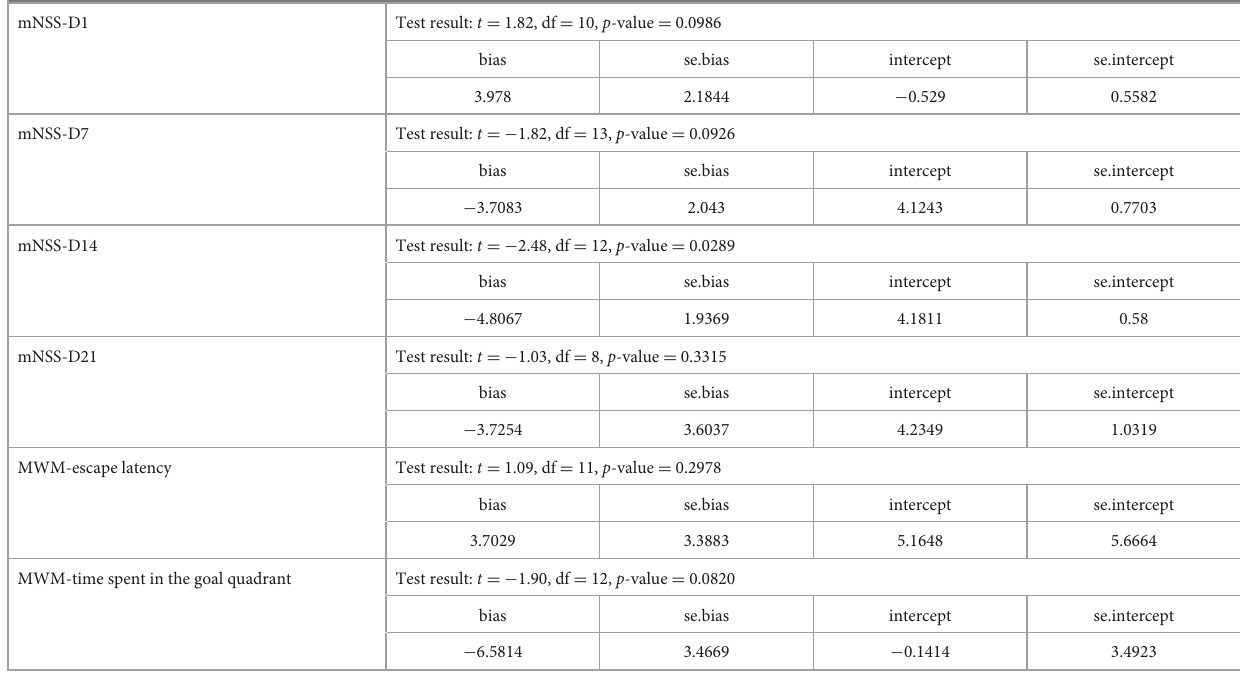
TABLE 2 Egger’s test of relevant outcome indicators. Linear regression test of funnel plot